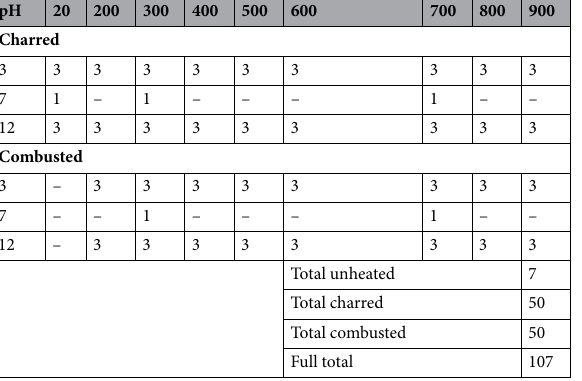
Table 1. Overview of the samples used for the preservation experiments. pH 3 and pH 12 experiments were carried out in triplicate, single samples of selected temperatures were incubated in pH 7 solutions as control